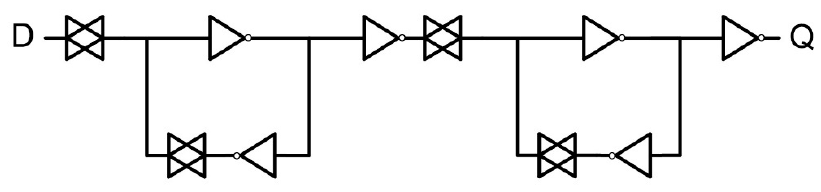
Figure 2. Reference master–slave flip-flop design using standard back-to-back inverter latches.